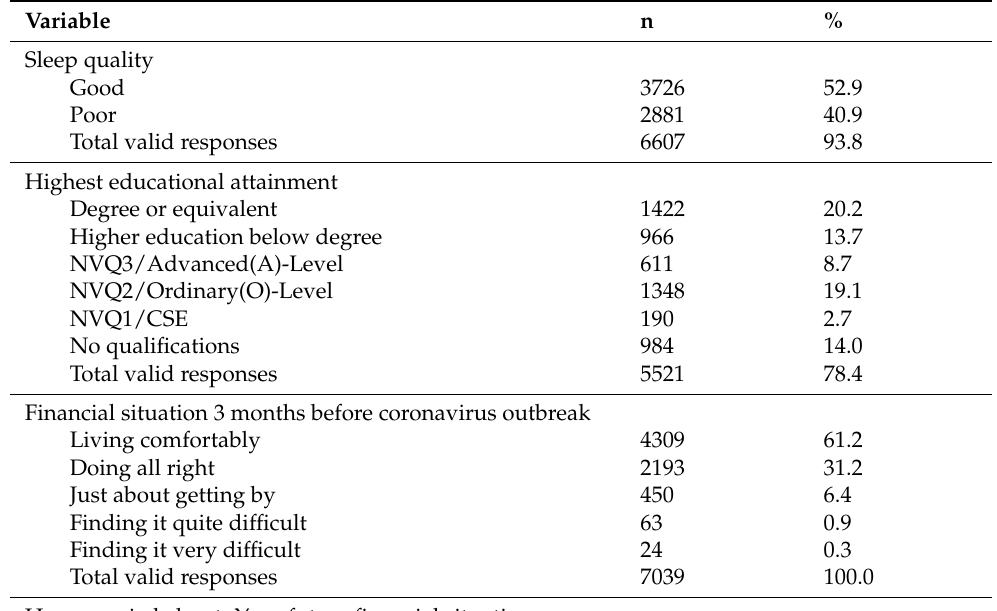
Table 1. General Characteristics of the Study